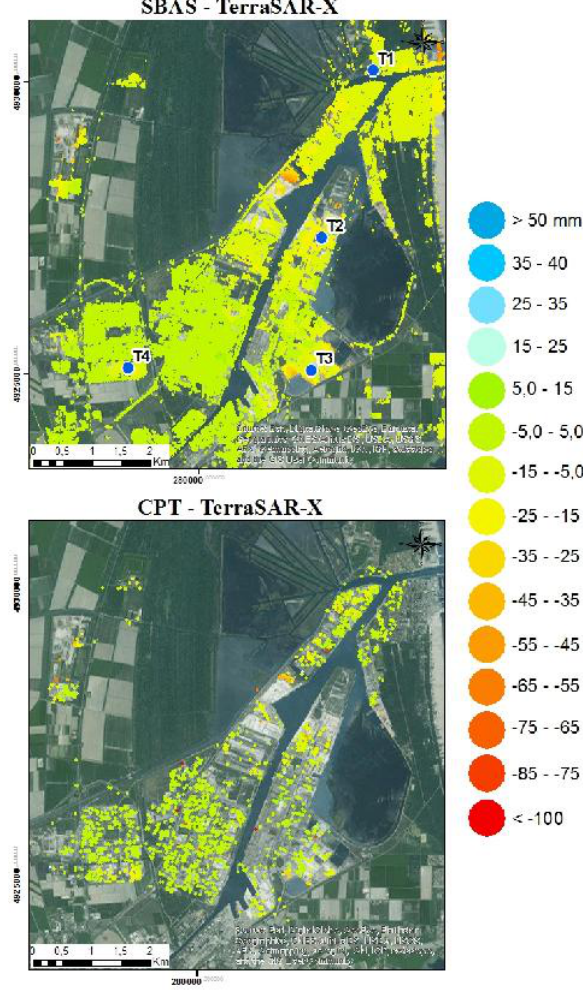
Figure7. Comparison between the displacement maps obtained with SBAS (above) and CPT (under) for the TerraSAR-X